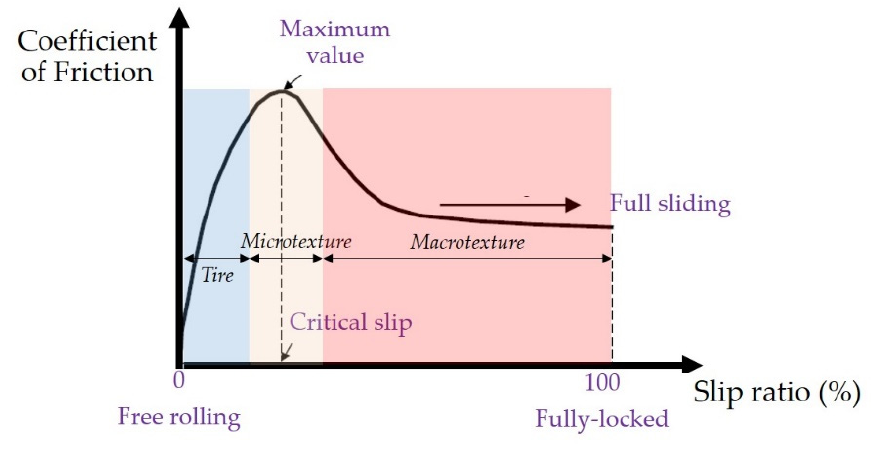
Figure 3. Friction versus tire slip (adapted from [33]).